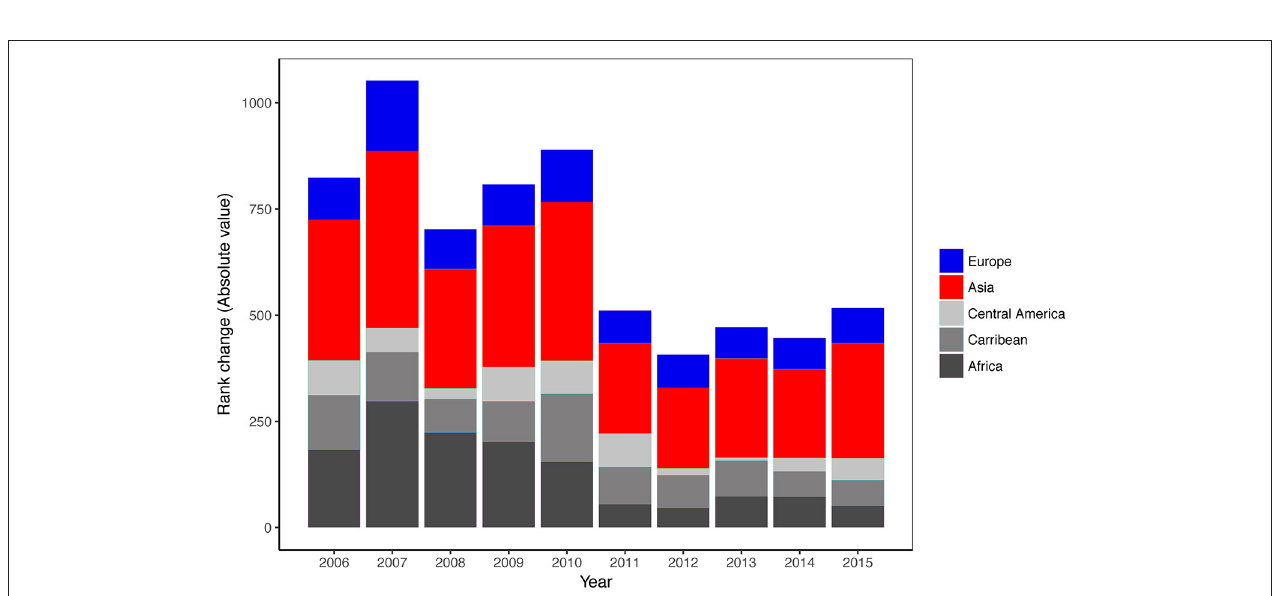
FIGURE 1 | Direct trade and re-export of Homarus spp. Global (2015) (Left) trade of Homarus spp. from producer-nations accounting for direct trade only. (Right) All trade of Homarus spp. including re-export (red). Width of edges between nations indicates relative value (US$) of trade.